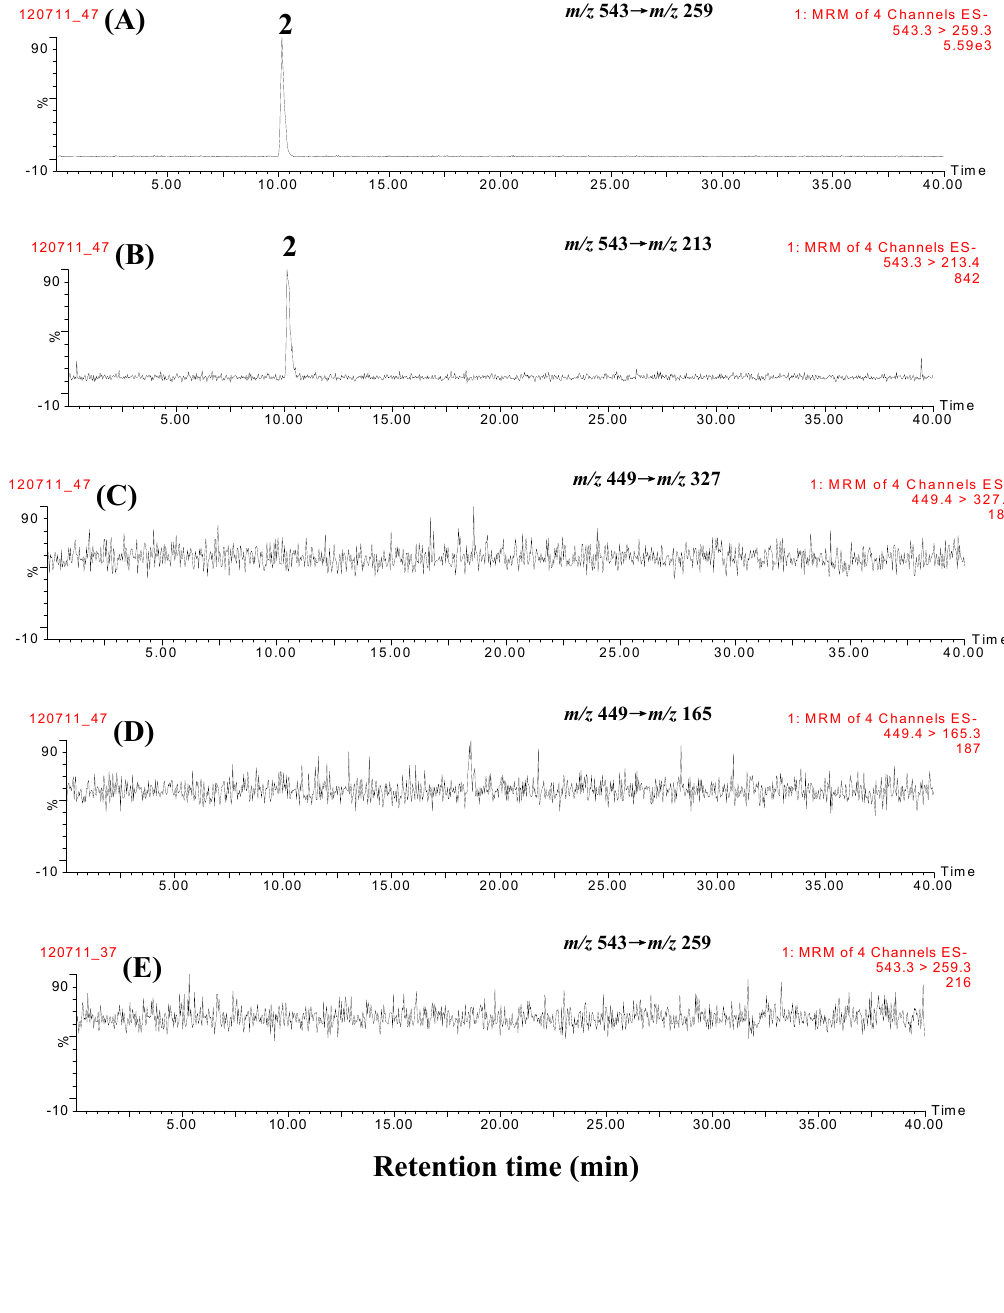
Figure 4. Representative chromatograms of marker compounds and PAR by MRM scan. ( A ) paeoniflorin sulfonate ion transition m/z 543 → m/z 259; ( B ) paeoniflorin sulfonate ion transition m/z 543 → m/z 213; ( C ) paeoniflorin sulfonate ion transition m/z 449 → m/z 327; ( D ) paeoniflorin sulfonate ion transition m/z 449 → m/z 165; ( E ) paeoniflorin ion transition m/z 543 → m/z 259; ( F ) paeoniflorin ion transition m/z 543 → m/z 213; ( G ) paeoniflorin ion transition m/z 449 → m/z 327; ( H ) paeoniflorin ion transition m/z 449 → m/z 165; ( I ) non-fumigated PAR (JPACM-01-01) ion transition m/z 543 → m/z 259; ( J ) non-fumigated PAR (JPACM-01-01) ion transition m/z 543 → m/z 213; ( K ) non-fumigated PAR (JPACM-01-01) ion transition m/z 449 → m/z 327; ( L ) non-fumigated PAR (JPACM-01-01) ion transition m/z 449 → m/z 165; ( M ) fumigated PAR (JPACM-01-02) ion transition m/z 543 → m/z 259; ( N ) umigated PAR (JPACM-01-02) ion transition m/z 543 → m/z 213; ( O ) fumigated PAR (JPACM-01-02) ion transition m/z 449 → m/z 327; ( P ) fumigated PAR (JPACM-01-02) ion transition m/z 449 → m/z